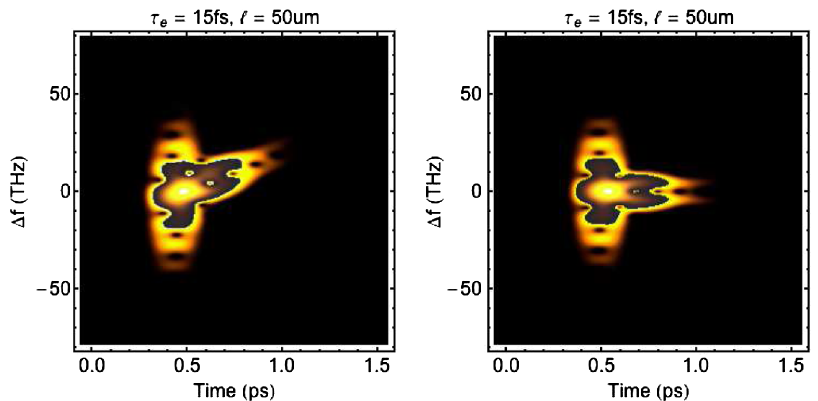
FIG. 4. Comparison between using a chirped (left) and transform limited (right) 500 fs probe pulse to measure a 15 fs bunch through a 50 (cid:10) m crystal. Their total bandwidths are 20 and (cid:7) 1 THz , respectively. Each image is shown using a 100 times filter to emphasize frequency mixing. The unfiltered image is inserted by overlaying it on the saturated portion of the filtered image (central